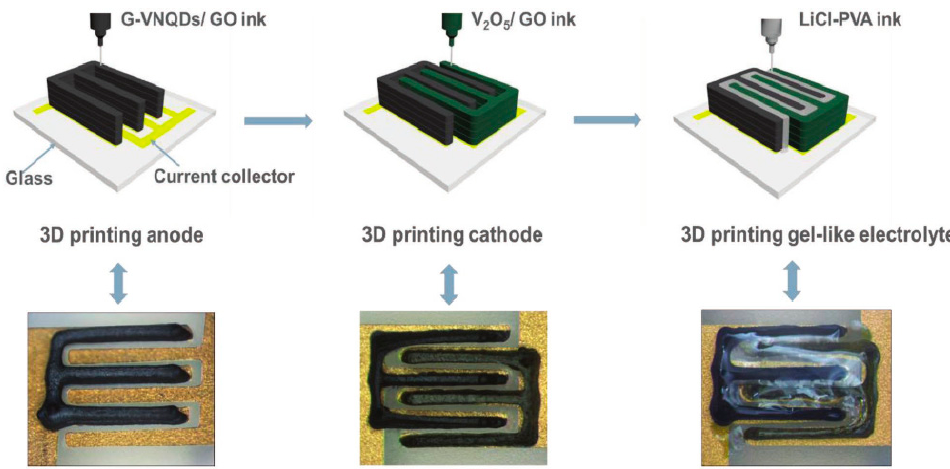
Figure 19. Schematic of a 3D printed micro supercapacitor. The GO composite ink was first printed as an electrode, then PVA/LiCl electrolyte was printed, and a full-printed supercapacitor was prepared. Reproduced from [107], with permission from Wiley, 2018.